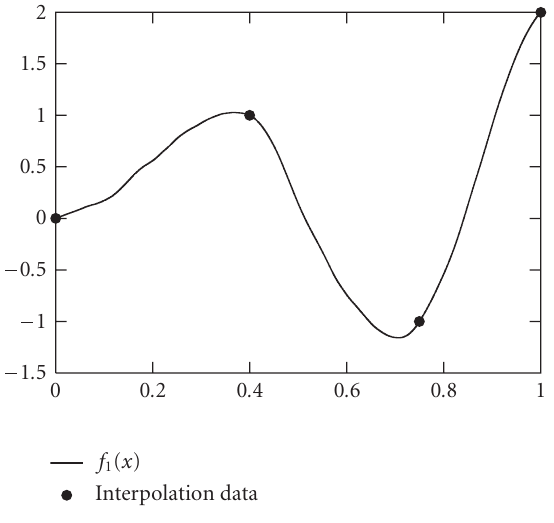
Figure 5.5. E ff ect on spline CHFIF by a change in the hidden variables γ n .